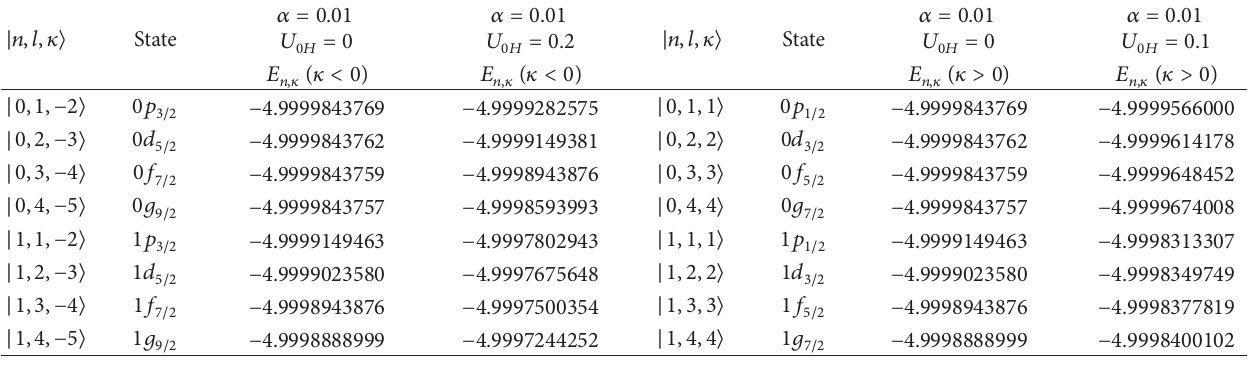
Table 3: The bound state energy eigenvalues in unit of fm −1 of the spin symmetry Hulth´en potential for several values of 𝑛 and 𝜅 . Here the first and second states column according to (𝑙,𝑗) .